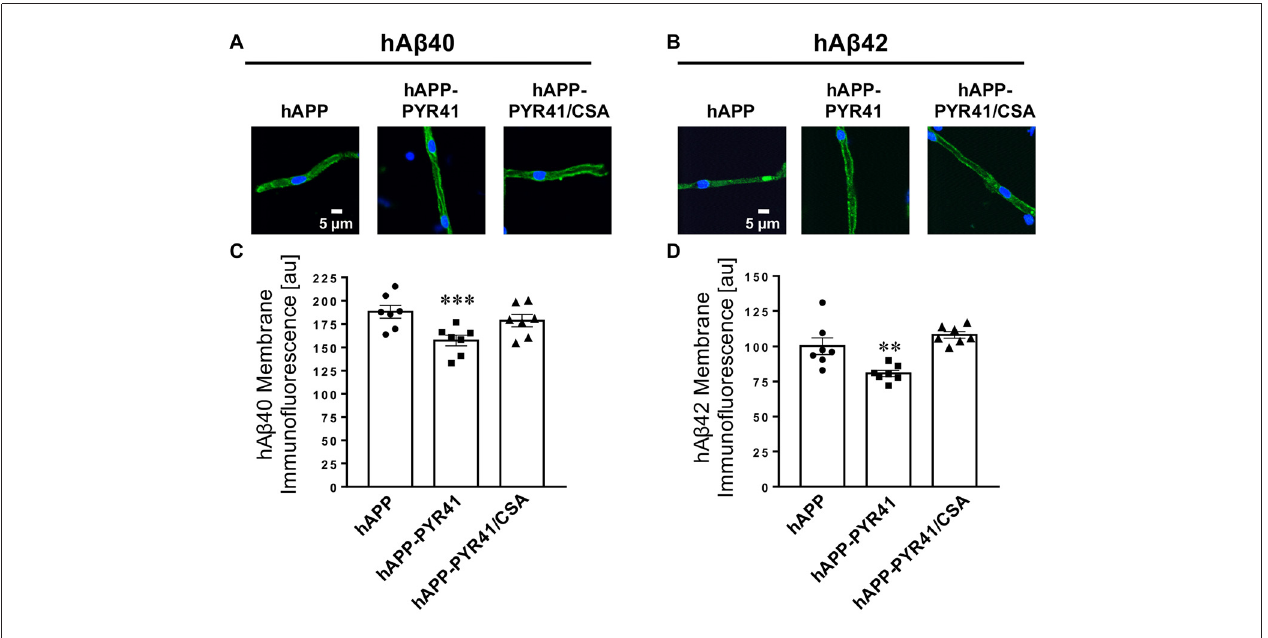
FIGURE 6 | PYR41 treatment reduces A β levels in brain capillary membranes. Representative confocal images of (A) hA β 40 -immunostained and (B) hA β 42 -immunostained brain capillaries isolated from vehicle-, PYR41- and PYR41/CSA-treated hAPP mice. Data from image analysis with ImageJ show that (C) hA β 40 and (D) hA β 42 membrane immunofluorescence is lower in capillaries isolated from PYR41-treated hAPP compared to control hAPP mice and mice that received PYR41/CSA. Data are mean ± SEM ( n = 7 brain capillaries per treatment group); shown are arbitrary fluorescence units (scale 0–255). Statistics: ∗∗ p < 0.01 (ANOVA), ∗∗∗ p < 0.001 (ANOVA) significantly lower than hAPP vehicle-treated